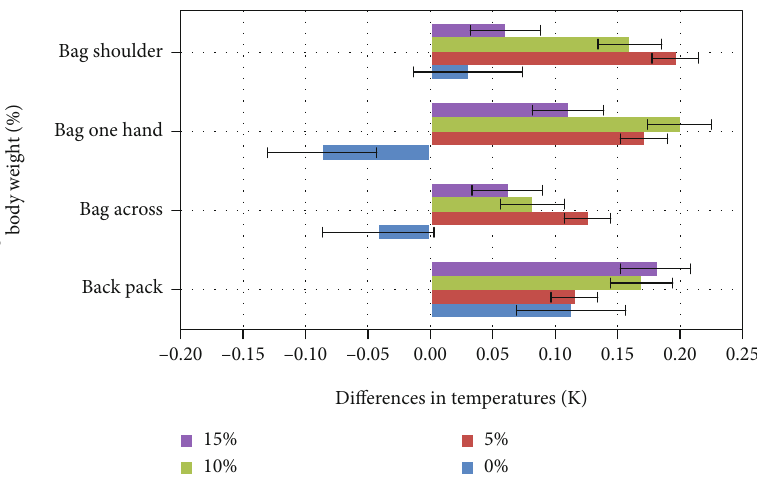
Figure 3: Average di ff erences for latissimus in the function of normalized load.